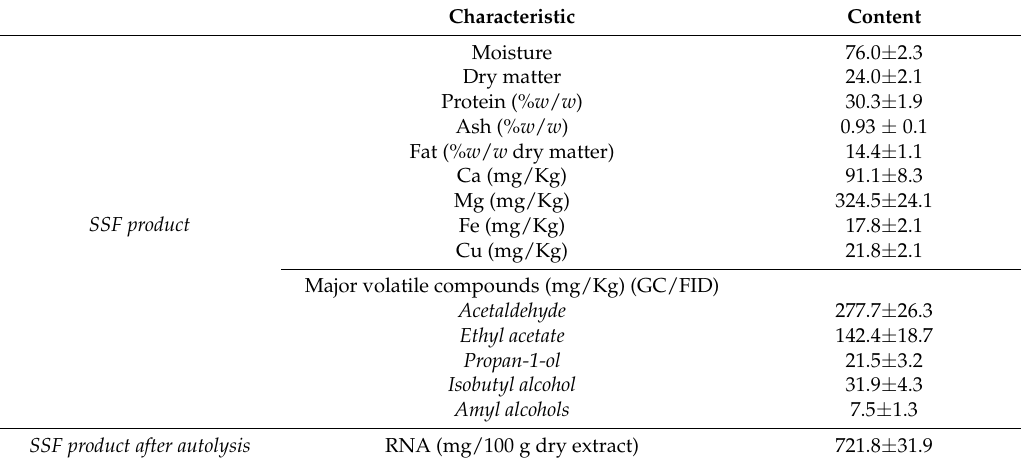
Table 4. Composition of the product of S7 SSF by P. ostreatus and its